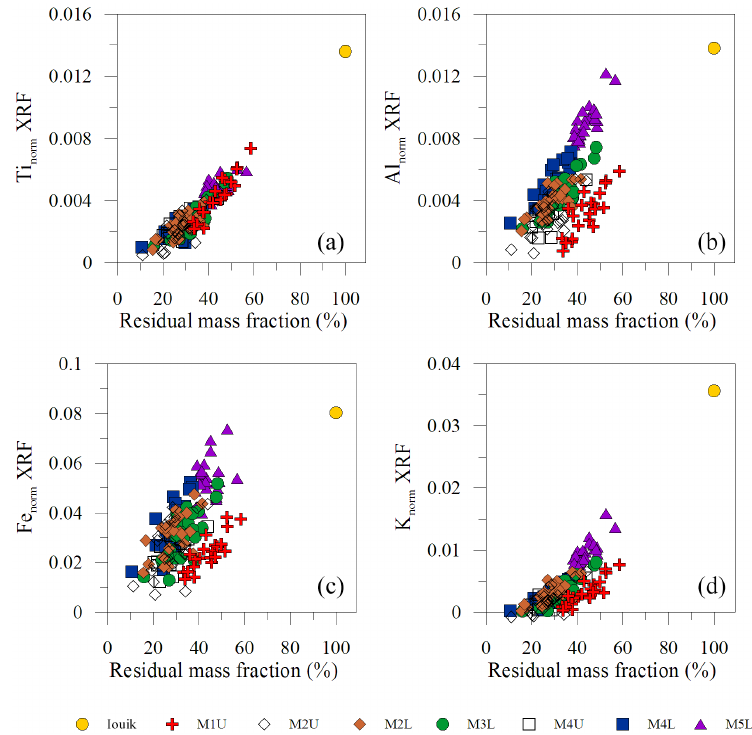
Figure 6. Comparison of the lithogenic elements Ti (a) , Al (b) , Fe (c) and K (d) , normalized to total XRF counts versus the residual mass fraction in all sediment traps and the average of the land-based dust collectors in Iouîk.